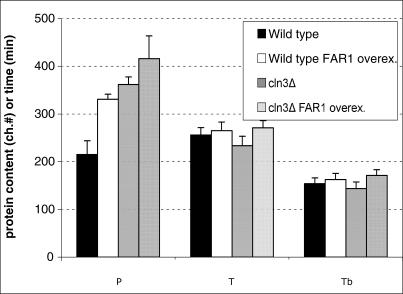
Control of Cell Size by Far1 Acts through Cln3Protein content (P; [i.e., the average protein content determined using flow cytometry of FITC-stained cells]), doubling time (T), and length of the budded phase (Tb) for wild-type (black bar, control; white bar, FAR1 overexpression) and cln3Δ strain (dashed bar, normal; checkered bar, FAR1 overexpression). Protein content is expressed as arbitrary units (i.e., channel number determined from FACS analysis), T and Tb in minutes.